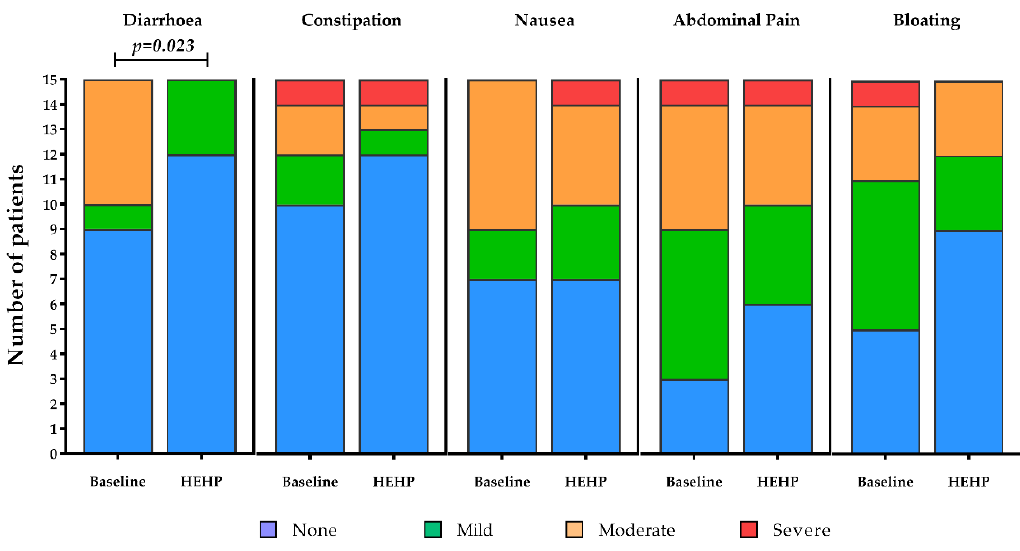
Figure 2. Incidence (number of patients) and intensity of diarrhoea, constipation, nausea, abdominal pain and bloating recorded on a 4-point Likert scale (Absent, Mild, Moderate, Severe) at baseline and with the intervention feed, as depicted by the HEHP bars.